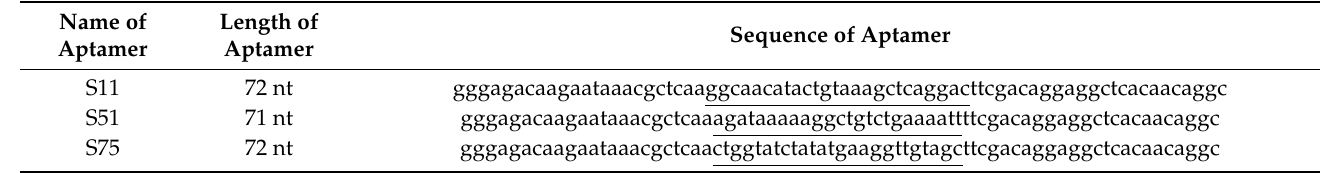
Table 1. Sequences of the aptamers eluted under stringiest conditions in all selection conditions against both